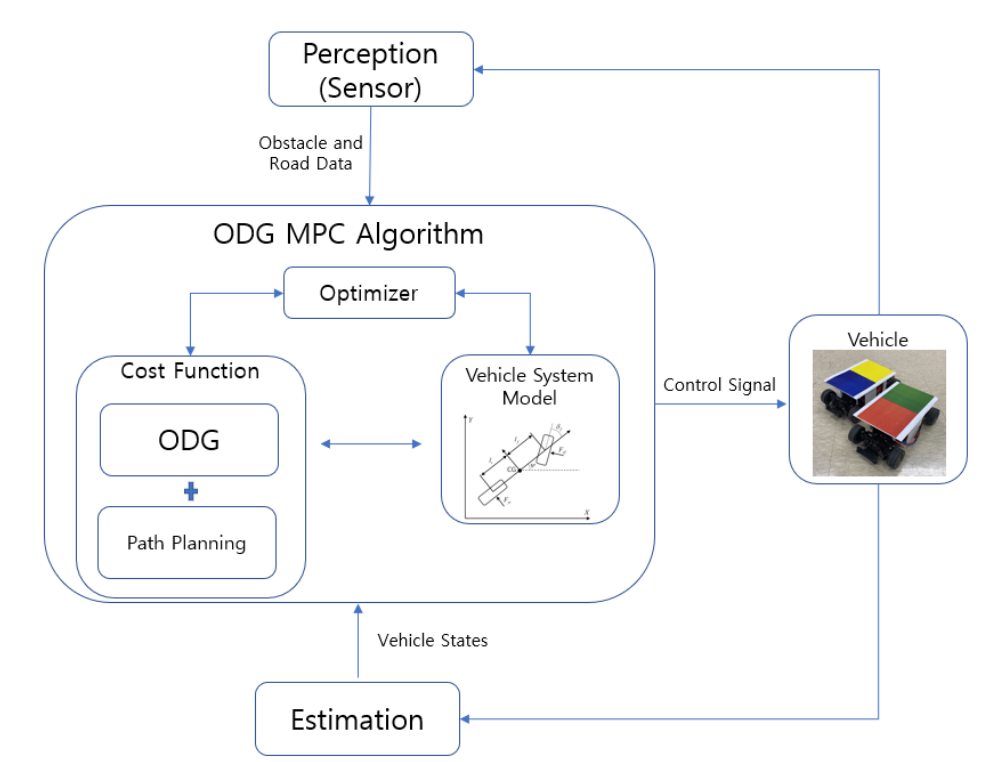
Figure 7. Obstacle-dependent Gaussian model prediction control architecture.